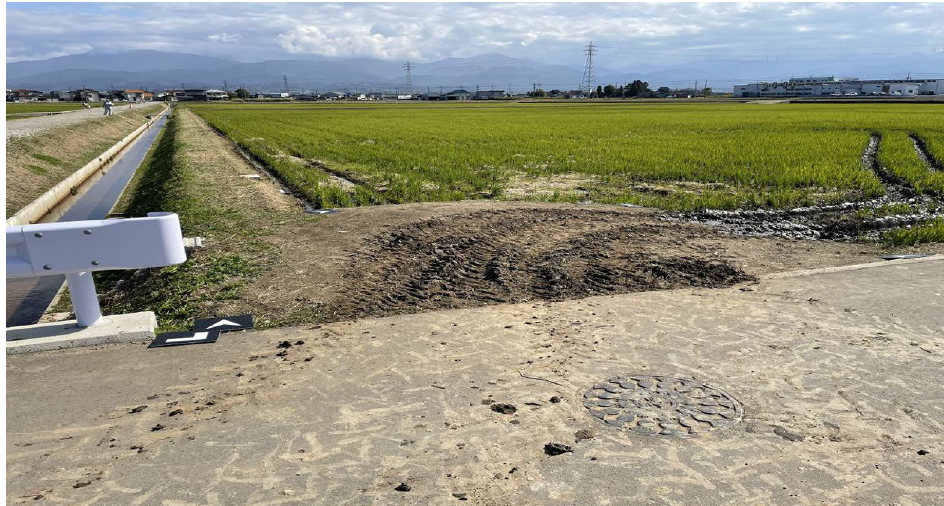
Fig. 2 Surrounding environment of an agricultural robot